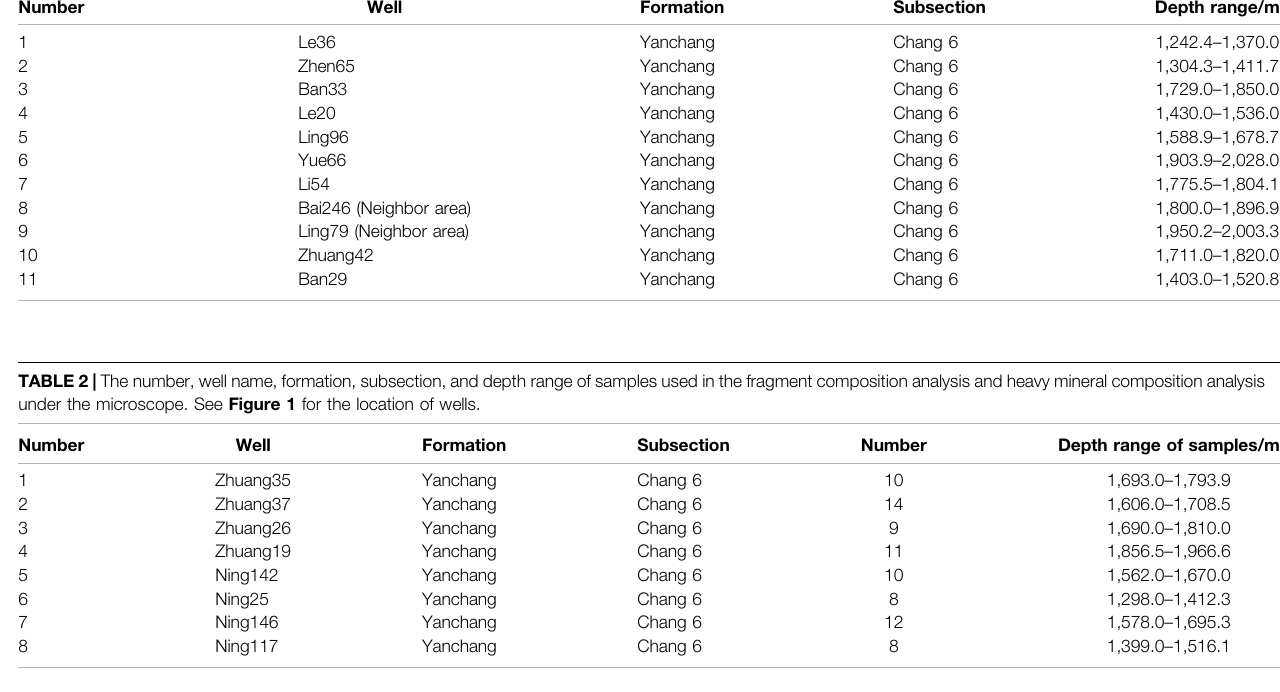
TABLE 1 | The number, well name, formation, subsection, and depth range of wells used in the core observation and description. See Figure 1 for the location of wells. Number